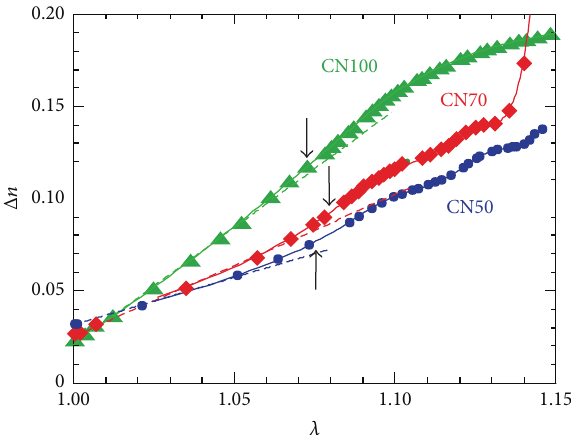
Figure 6: The optical birefringence, Δ𝑛 versus 𝜆 , shows a mono- tonic increase in orientational order for CN50, CN70, and CN100. The symbols show the 𝜆 data points from Figure 5. As 𝜆 → 1 , Δ𝑛 is linear in 𝜆 (dashed lines) in all samples up to the value of 𝜆 at 𝑇 ∗ (highlighted by arrows) in CN70 and CN100. The deviation from linearity in CN50 is below 𝑇 ∗ . In CN70, Δ𝑛 departs from saturation type behavior at large 𝜆 in the proximity of an estimated glass transition at 𝑇 𝑔 ≃ 17 – 20 ∘ C.